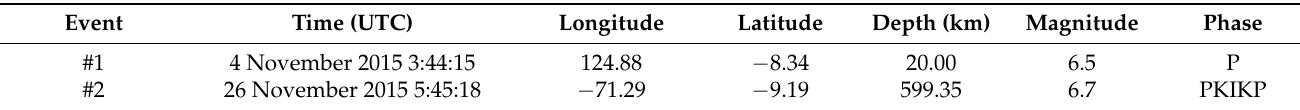
Table 2. Parameters of seismic events (parameters from USGS).